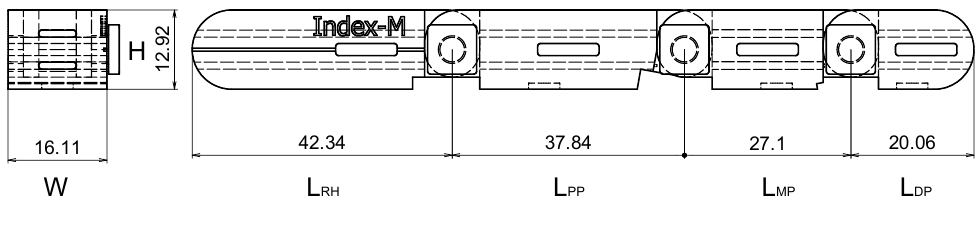
Figure 4. Dimensions of the dummy